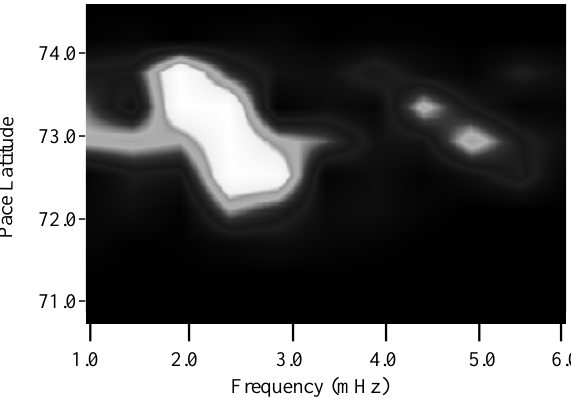
Fig. 4. Latitude dependent power spectra for the optical data in Fig. 3. Power is in arbitrary units, with white indicating the largest